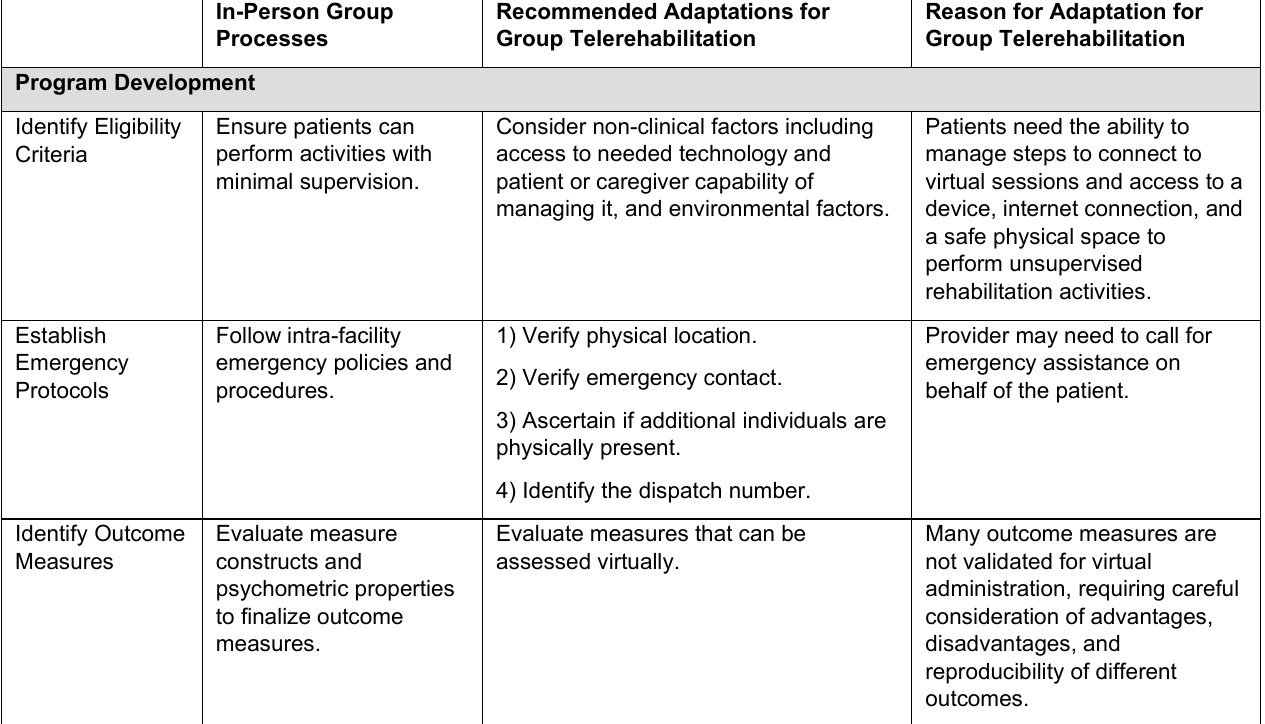
Identified Adaptations for Development and Implementation of an In-person Group to Telerehabilitation Group In-Person Group Recommended Adaptations for Processes Group